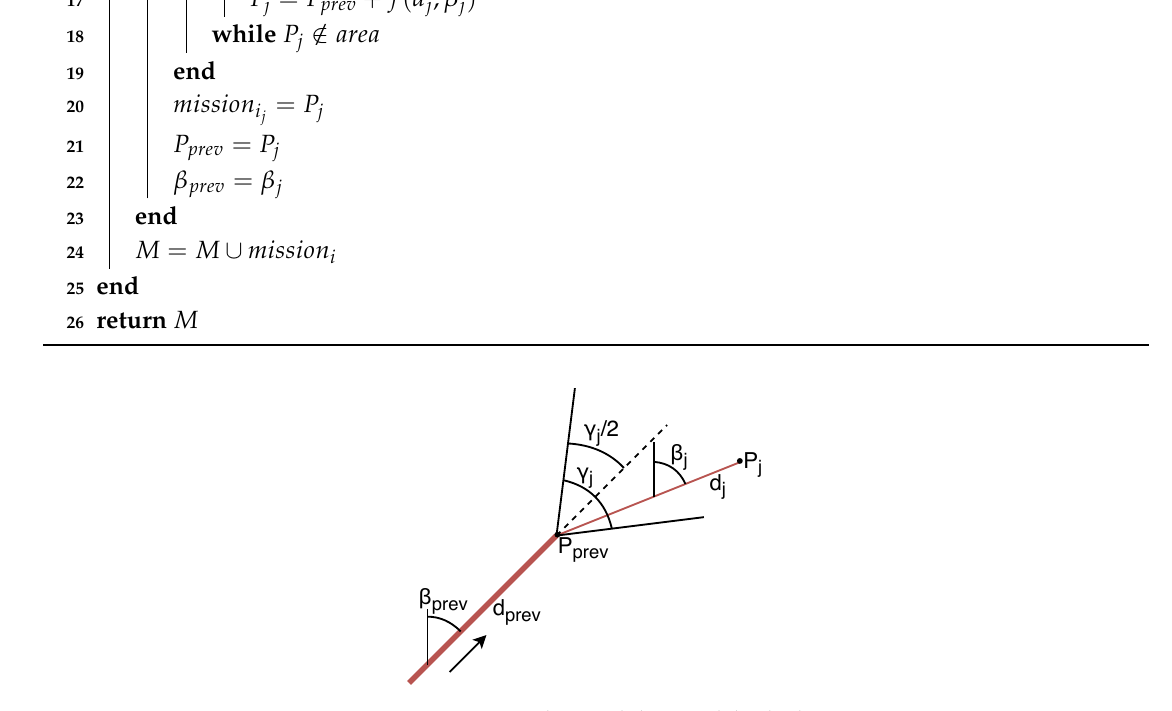
Figure 15. Gauss–Markov mobility model